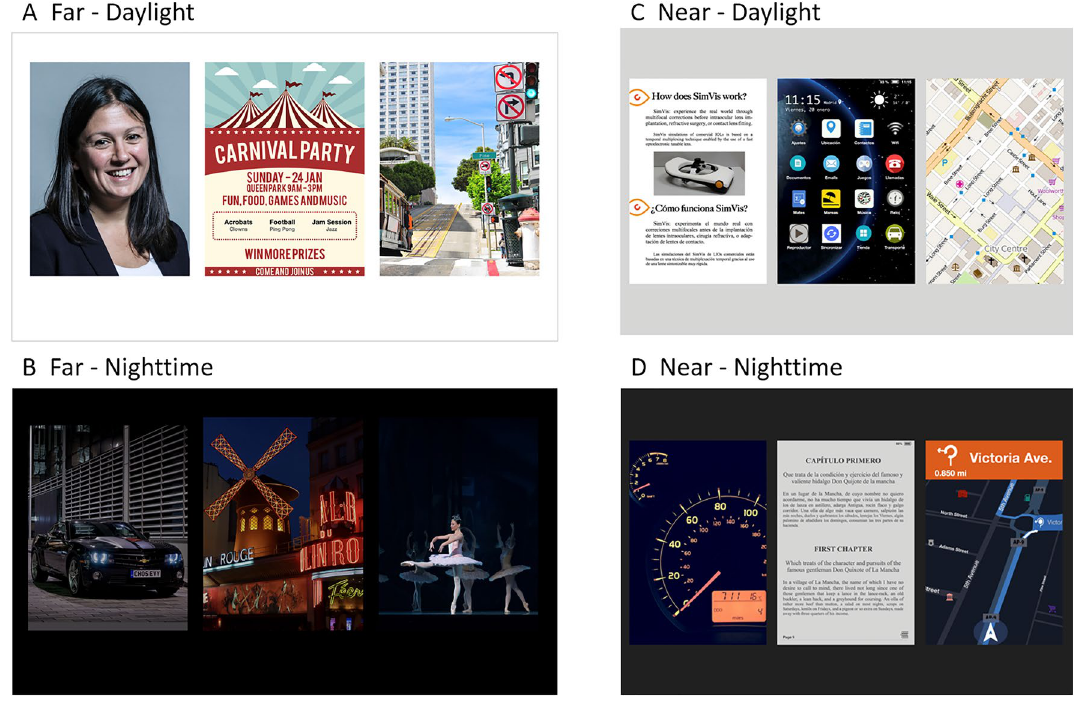
Figure 1. Set of images of MAS-2EV (CC BY open access license, further details in Acknowledgments and Attributions section).